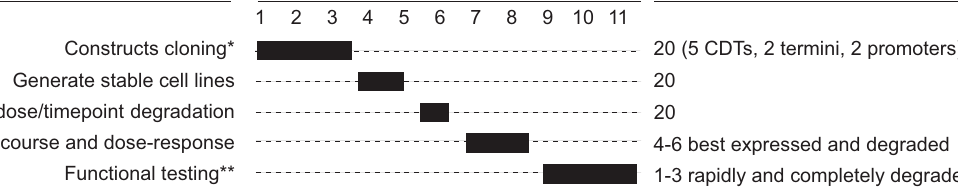
Fig. 5 | A systematic approach to developing CDT fusions for target validation studies. a Schematic summaryof functionalconsequencesofdifferent expression levelsand degradation potencies. In thisexample, CDT1 isa degron fusion protein in which degradation is not suf fi ciently potent to phenocopy inactivation of the targetgene;CDT2iseitherhypomorphicornotexpressedathighenoughlevelsto functionally replace the endogenous gene; CDT3 is the ideal situation where the degron fusion protein phenocopies both the expression of the endogenous gene